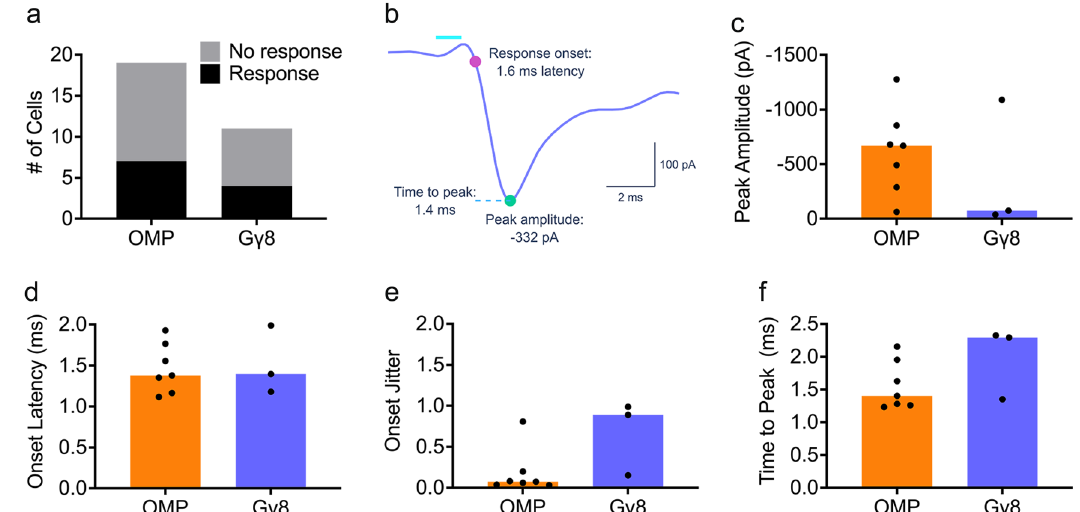
Fig. 8 | Immature OSNsprovide monosynapticinput to super fi cialtufted cells. a A similar proportion of recorded STCs from both OMP-ChIEF-Citrine and G γ 8- ChIEF-Citrine miceresponded monosynaptically to photoactivation (Fisher ’ s exact test. P >0.99, n =19 cells from 10 OMP-ChIEF-Citrine mice and 11 cells from 5G γ 8- ChIEF-Citrine mice). One STC from the G γ 8-ChIEF-Citrine group showed a mono- synapticresponsetooptogeneticstimulationwitha1ms,50%intensitylightpulse, but its dataset was incomplete and lacked sweeps for 1ms, 100% intensity light stimulation. Data for optogenetic stimulation with a 1ms, 50% intensity light pulse areshowninFig.S8. b Propertiesofeachlight-evokedresponseanalyzed:response onset,timetopeak,and peakamplitude. c – f Dataforoptogeneticstimulationwith a 1ms, 100% intensity light pulse. c Median peak amplitudes were not signi fi cantly different between OMP-ChIEF-Citrine and G γ 8-ChIEF-Citrine mice (Mann – Whitney test. P =0.52, U =7, n =7 cells from 5 OMP-ChIEF-Citrine mice, and n =3 cells from